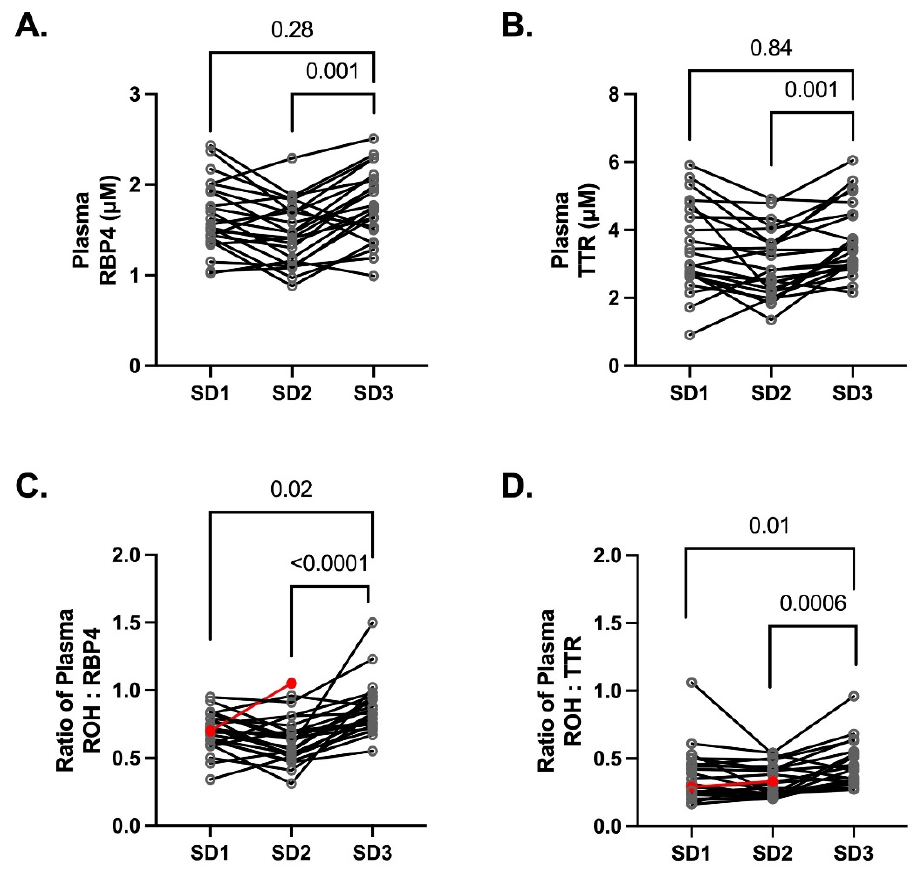
Figure 3. The plasma ( A ) RBP4 and ( B ) TTR concentrations at 25–28 weeks gestation (SD1), 28–32 weeks gestation (SD2), and 3–4 months PP (SD3) were measured from 23 healthy pregnant women. The ratio of ( C ) retinol to RBP4 and ( D ) retinol to TTR were lower on both SD1 and SD2 in comparison to SD3. In panels C , D , one subject had insufficient sample to measure SD3 retinol concentrations (red symbols) and was excluded from the statistical comparison ( n = 22 pregnant women).